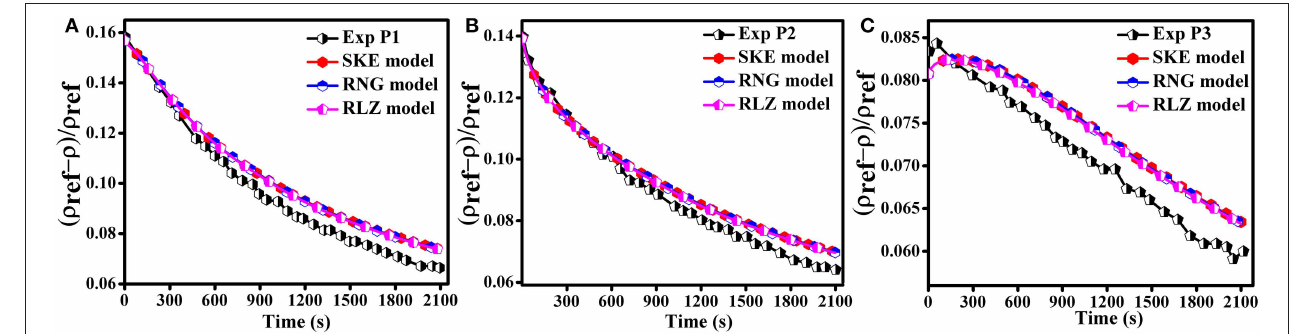
FIGURE 3 | Effect of air-injection velocity 0.411 m/s on the simulation results for monitors (A) P1, (B) P2, and (C) P3.